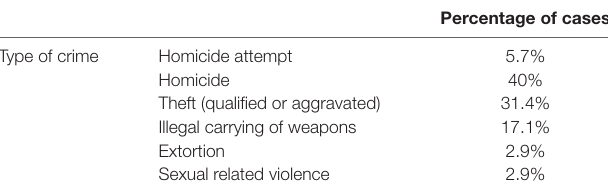
TABLE 2 | Description of type of offenses in the offender adolescents